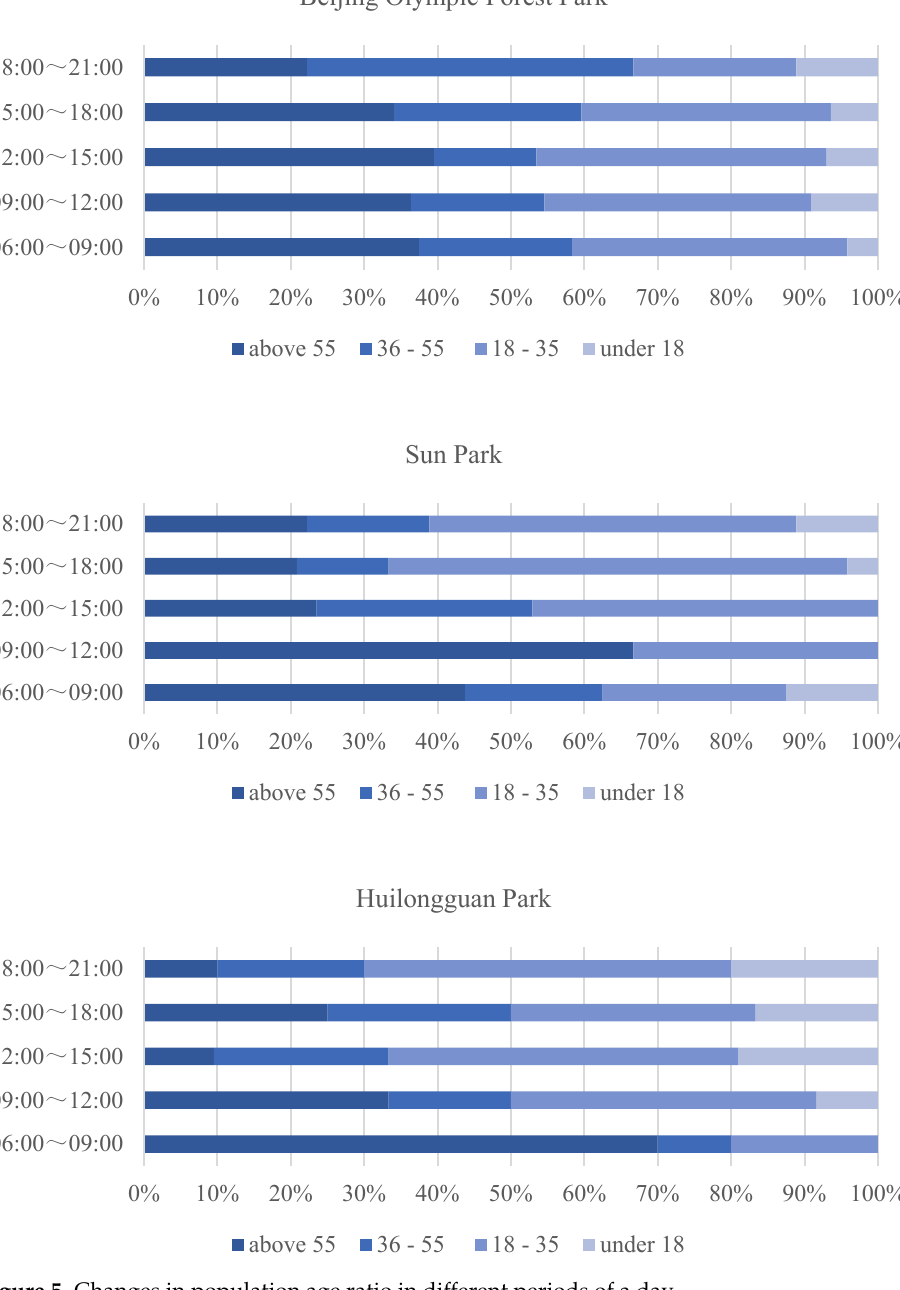
Figure 5. Changes in population age ratio in different periods of a day.